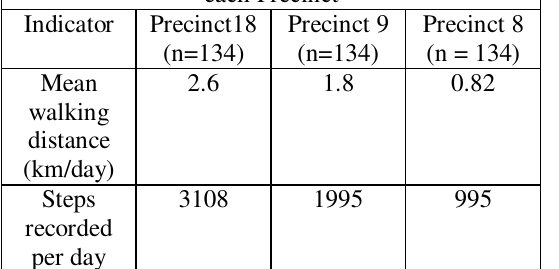
Table 1: Recorded Pedometer Walking Distance in each Precinct